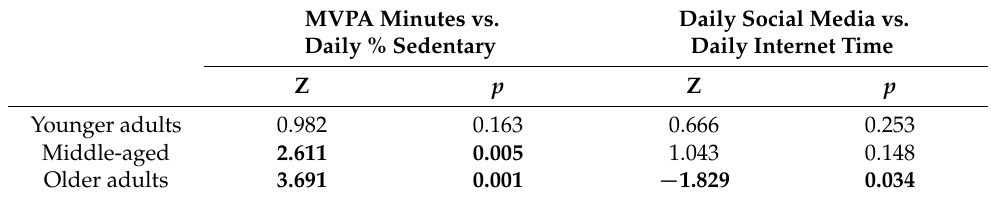
Table 4. Within age comparisons of the strength of association between lifestyle factors and sleep health. MVPA Minutes vs. Daily % Sedentary